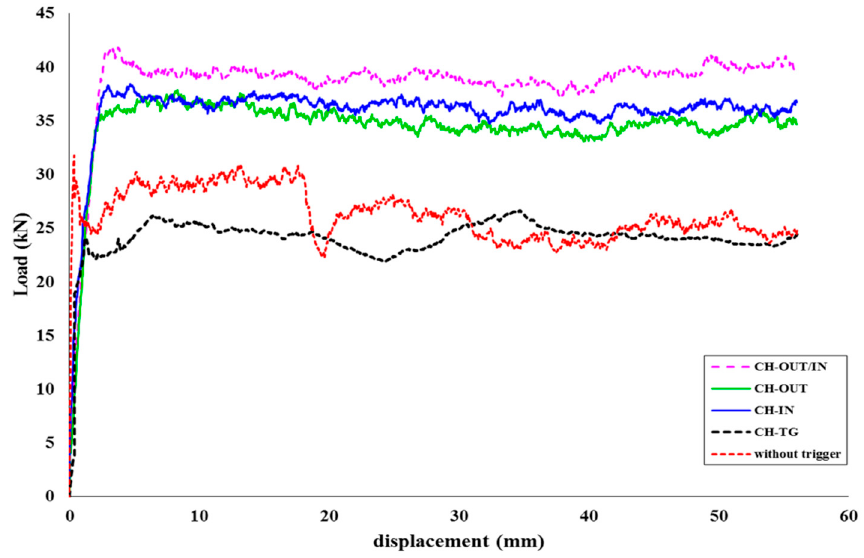
Figure 9. Comparison between triggered mechanisms and normal specimen based on load-displace- ment